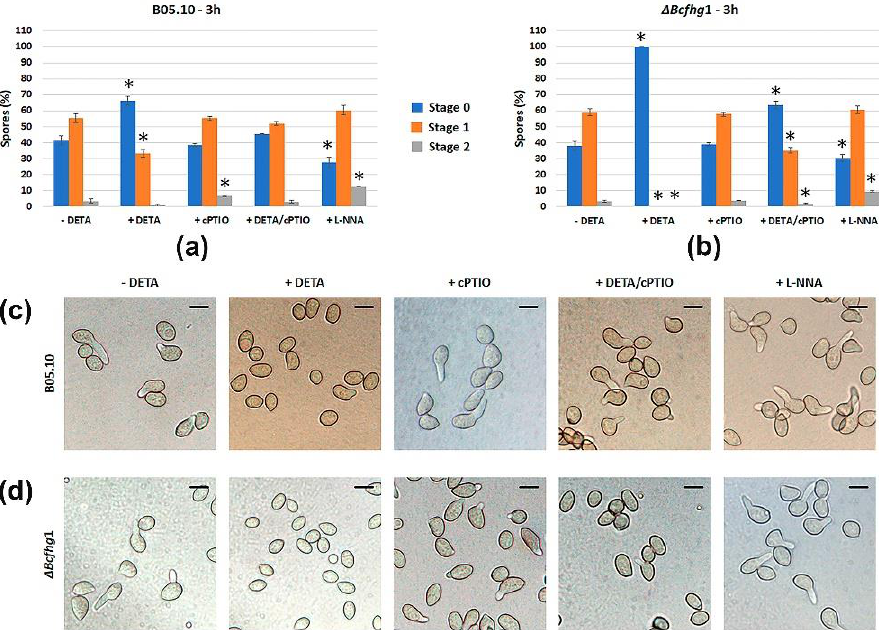
Figure 1. Effect of addition of the NO donor DETA, the NO scavenger cPTIO and the NOS inhibitor L-NNA on the germination of spores of the B. cinerea strains B05.10 ( a ) and ∆ Bcfhg 1 ( b ) after 3 h of incubation. The reagent concentrations were 250 µ M DETA, 500 µ M cPTIO, and 1 mM L-NNA. The graphs show the means of three replicates ± SD ( n > 100 each). (* indicates significant differences at p < 0.05—Student’s t -test—between each stage and treatment and its control stage in the absence of DETA.) ( c , d ) Representative images of the germination process of each strain at the same time point and treatments as in ( a , b ). Scale bars, 10 µ